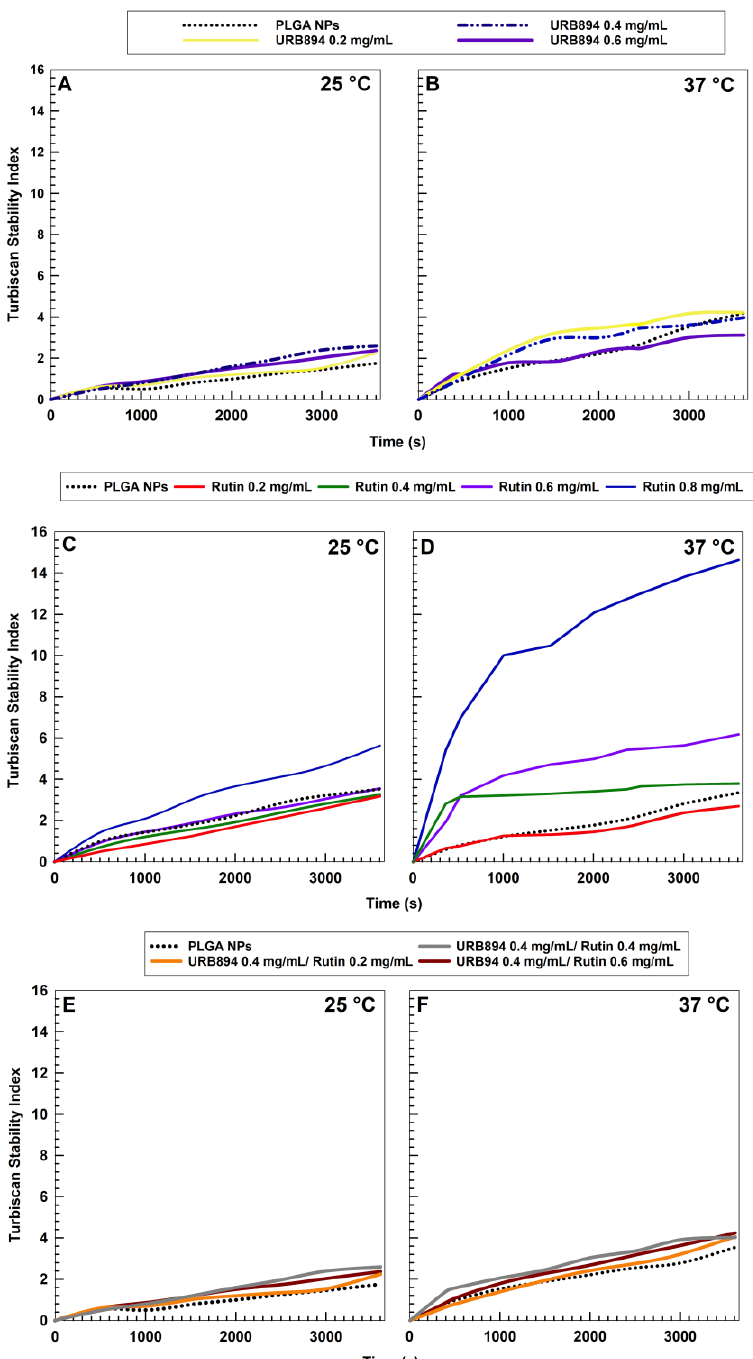
Figure 3. Turbiscan Stability Index (TSI) profiles of PLGA nanoparticles (NPs) prepared with various amounts of URB894 (0.2 – 0.6 mg/mL) or/and rutin (0.2 – 0.8 mg/mL) as single agents or as multidrug carriers (0.4 mg/mL of URB894 and 0.2 – 0.6 mg/mL of rutin, respectively) as a function of time and temperature. ( Panels ( A , C , E )): 25 °C. ( Panels ( B , D , F )): 37 °C. The reported result is a representative experiment of three independent tests.